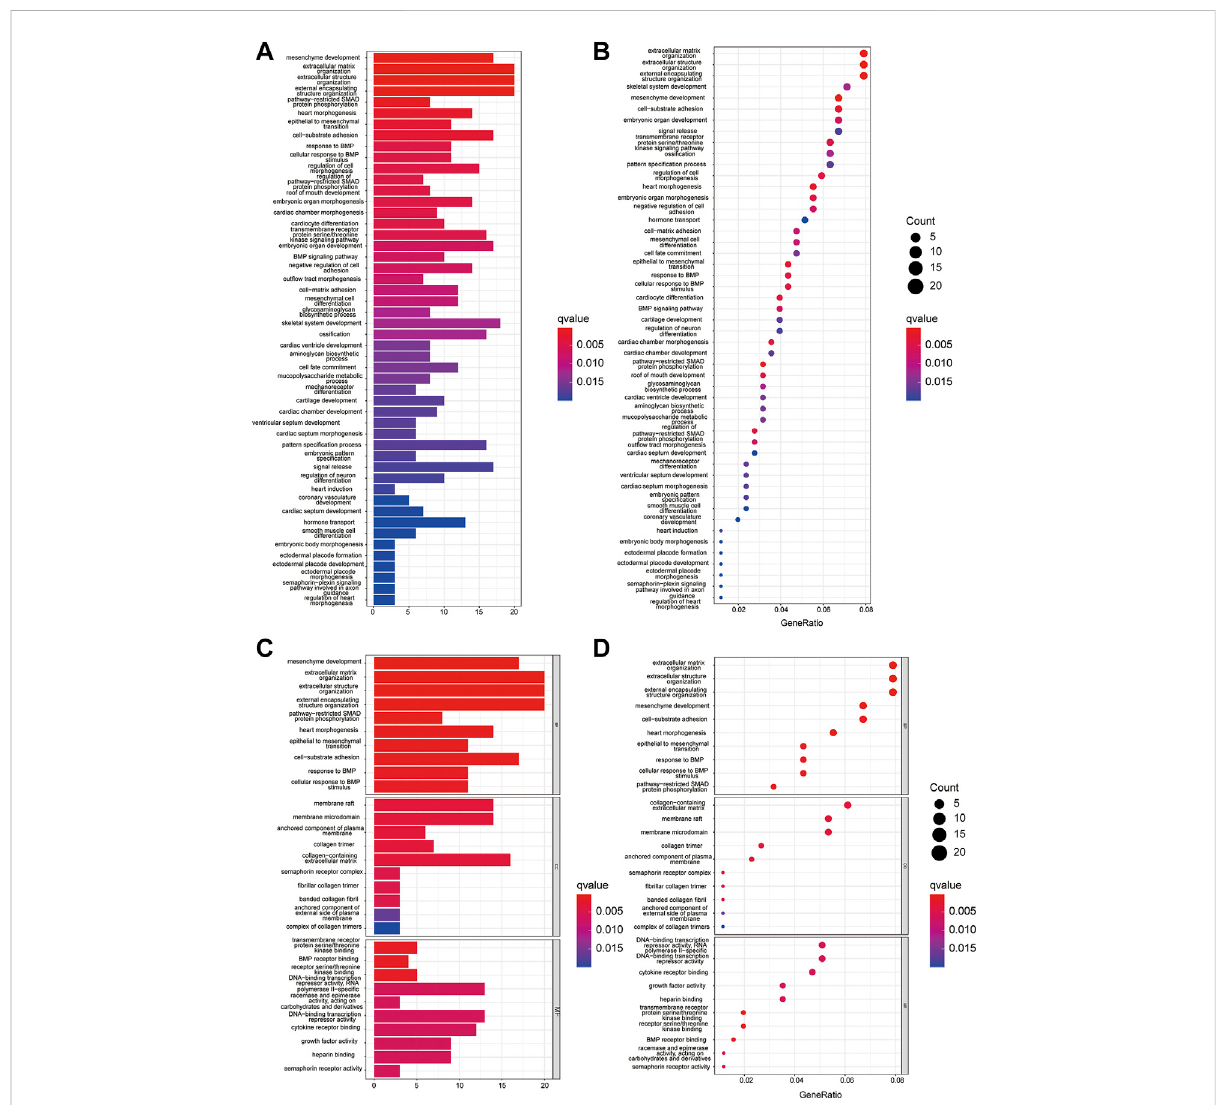
FIGURE 3 GO and KEGG enrichment analysis in TARGET dataset. (A,C) The KEGG (A) and GO (C) analysis by bar graph; (B,D) Bubble chart shows signi fi cantly enriched KEGG (B) pathway and GO (D) .